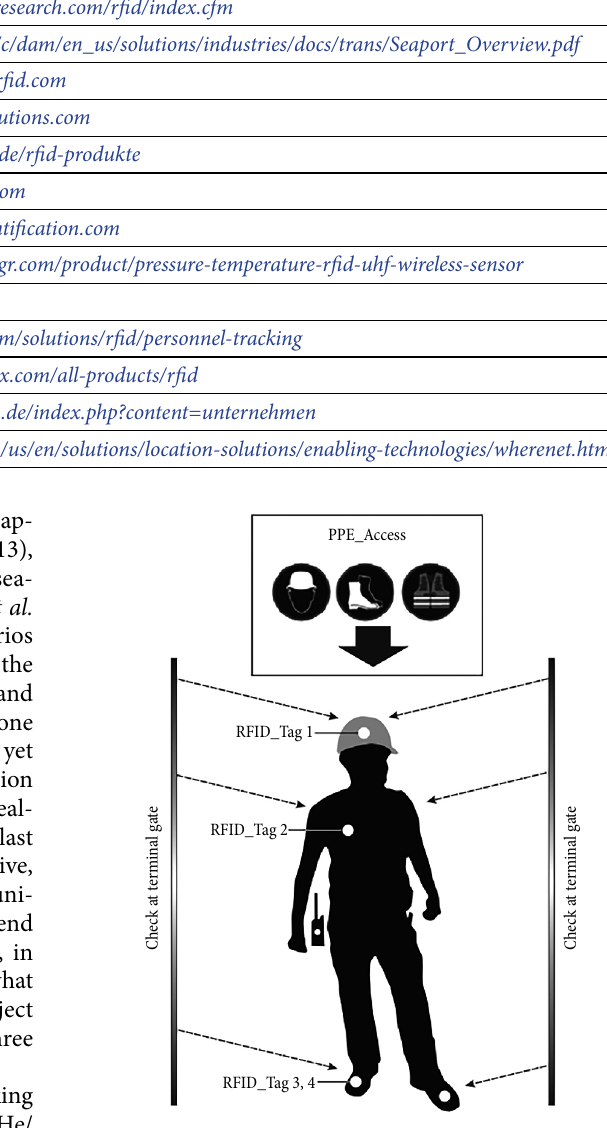
Fig. 1. Inspection of worker’s PPE at entrance gate – adapted from Kelm et al.